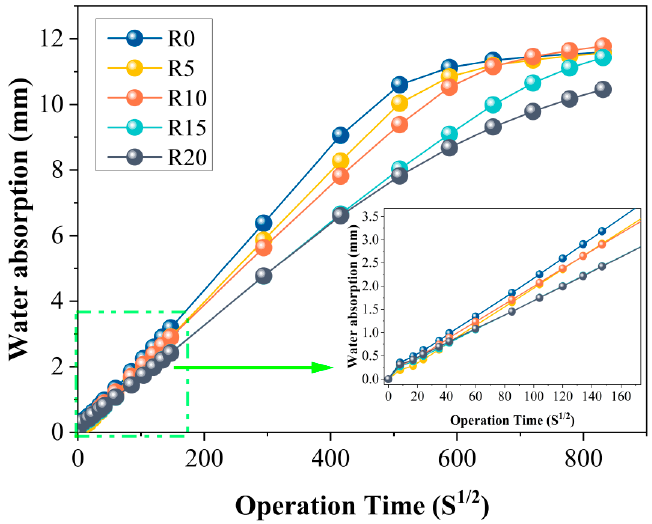
Figure 9. Capillary absorption of mortars.